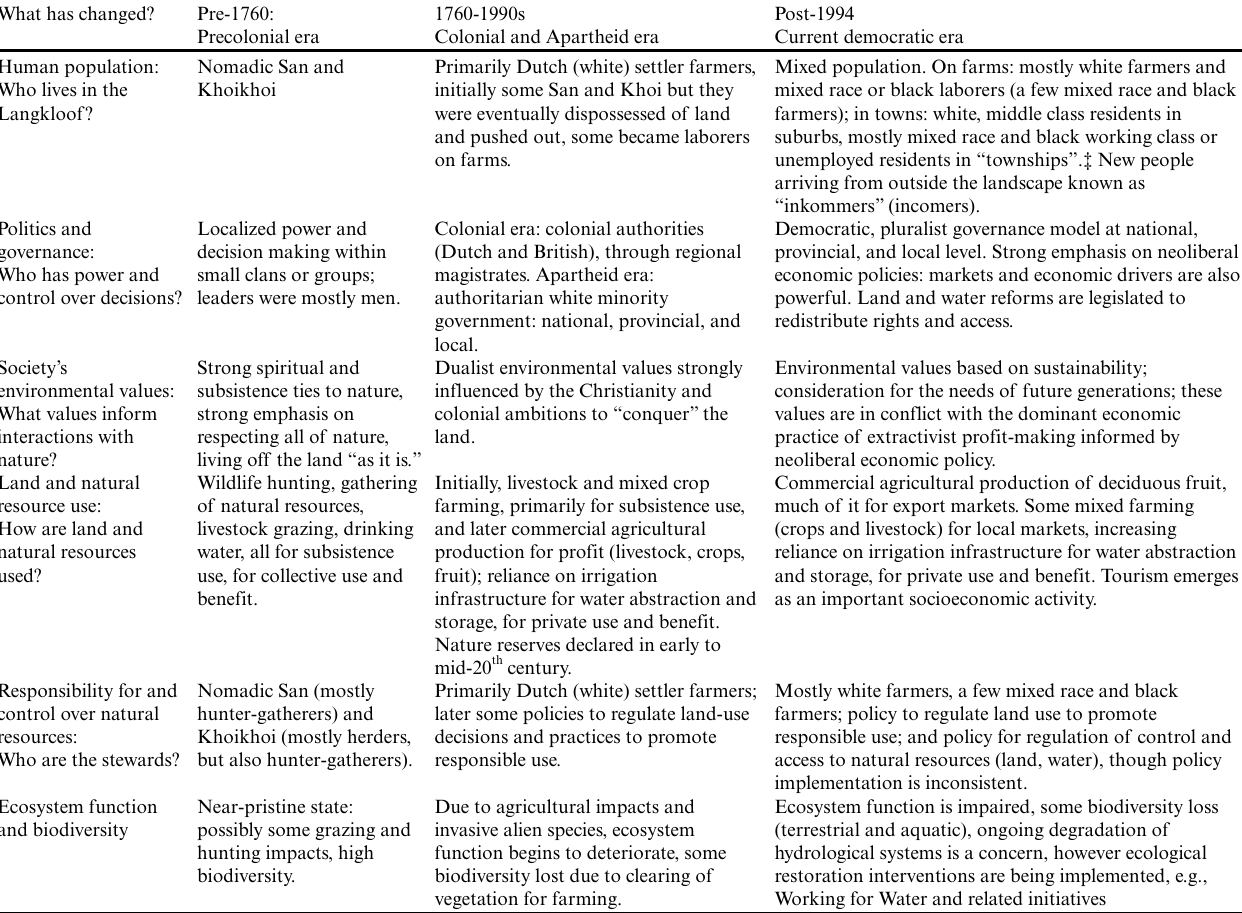
Table 1 . Historical timeline of social-ecological change in the Langkloof, based on a review of background documents and literature (du Toit 1931, Guelke and Shell 1992, Swiegers 1994, Ross 1997, Beinart 2000, van Huyssteen 2008, Hamann and Tuinder 2012, de Laat